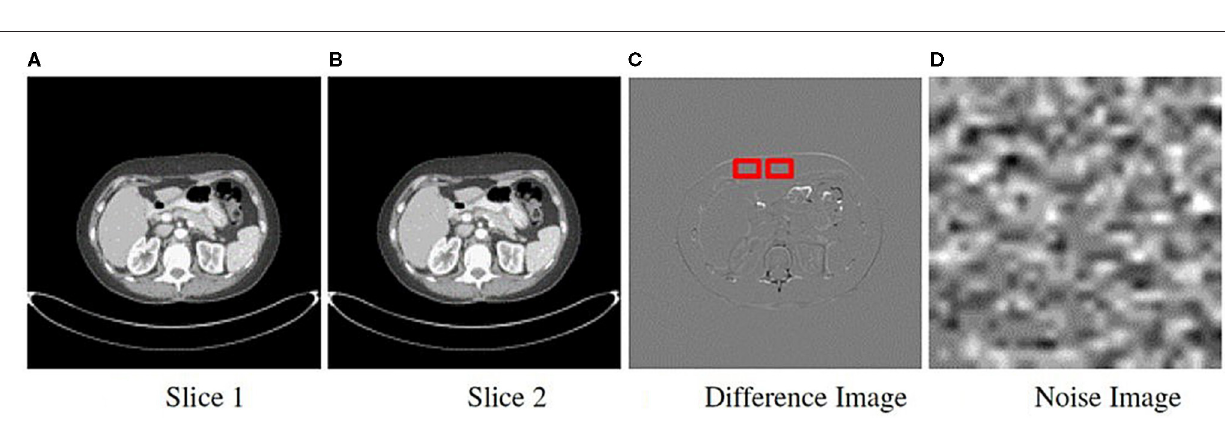
FIGURE 3 | Method to obtain noise maps from sequentially acquired images. Two sequential slice images are subtracted from each other (A,B) . (C) Difference image resulting from subtraction showing the sliding 30 × 30 pixel window used to extract uniform patches. (D) All patches were averaged to generate a single noise